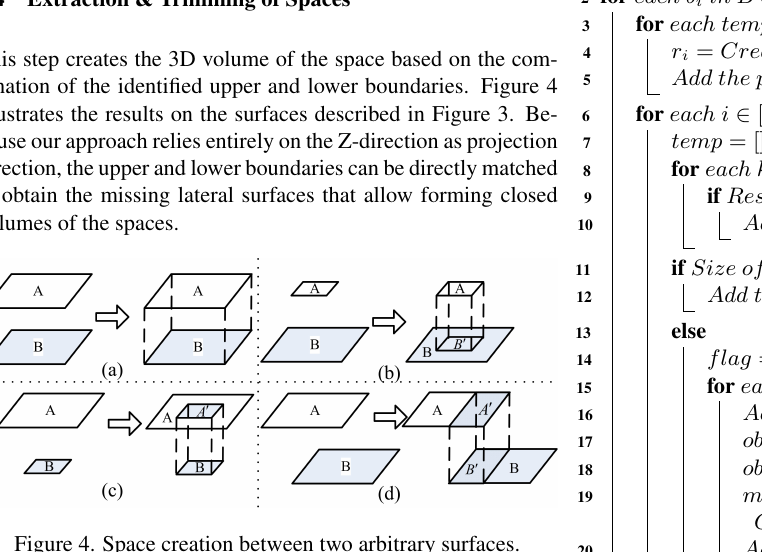
Figure 4. Space creation between two arbitrary surfaces.